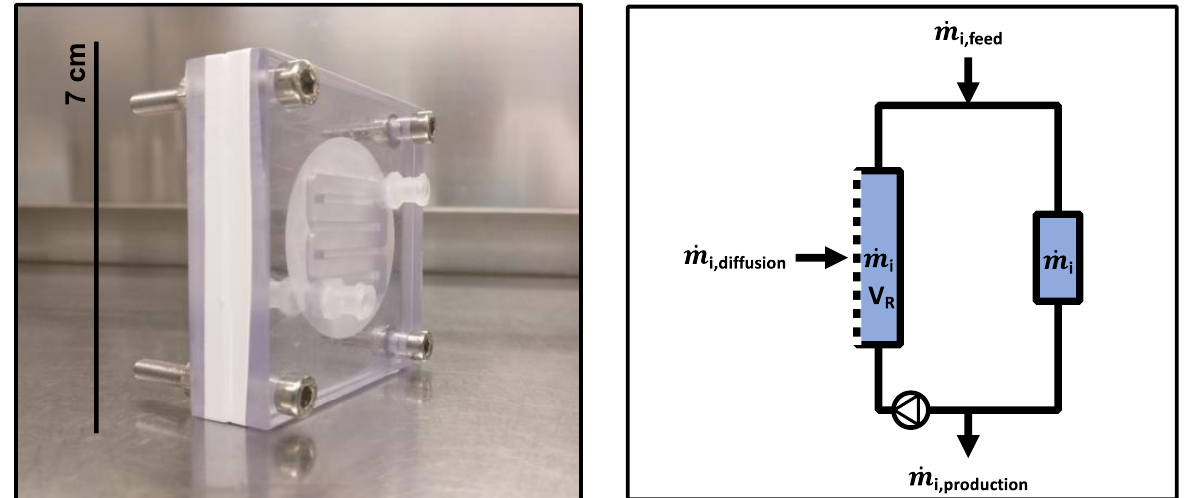
Figure 1. ( left ) Image of the membrane unit. The inlet and outlet of the channel were connected to vessels or tubes to allow the circulation of cells. Two polycarbonate elements were used to clamp a semi-permeable membrane that was aligned and fixed. ( right ) Mass balance of a compartment with inflow (feed), outflow (harvest), and diffusion flows in the membrane unit. The mixing pump allowed the circulation of the cultivation broth within the compartment.